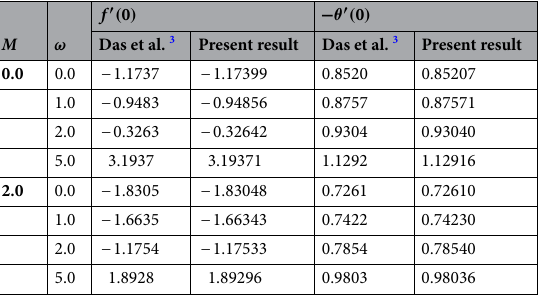
θ ′ ( 0 ) with Das et al. 3 for different value of ω when −